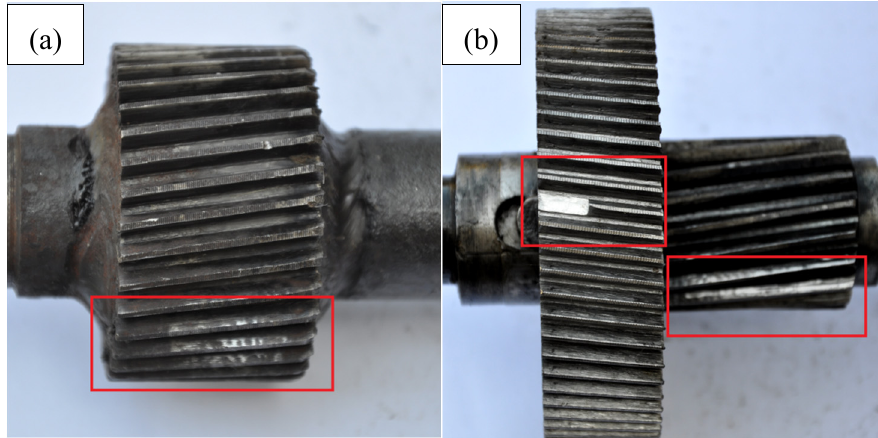
Figure 11. ( a ) HS shaft gear tooth wear; ( b ) intermediate speed (IS) shaft gears, tooth chip and wear.